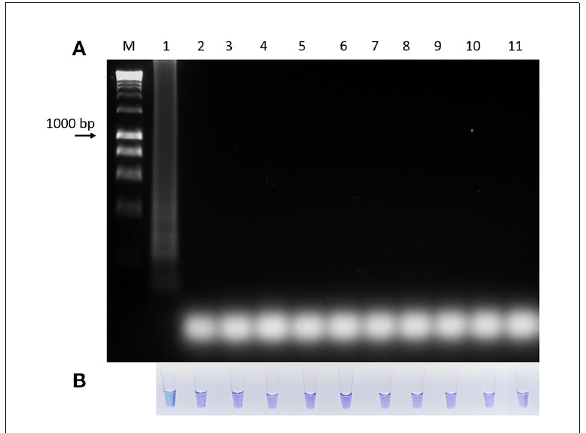
FIGURE4 Diagnostic specificity analysis of the LAMP technique for the detection of B. bigemina . (A) Electrophoresis in agarose gel at 1.2% of the products obtained from the specificity analysis. (B) Colorimetric test with hydroxynaphthol blue. Lanes: M) Molecular size marker in bp: (1) B. bigemina , (2) B. bovis , (3) Anaplasma marginale , (4) A. phagocytophilum , (5) A. centrale , (6) Trypanosoma theileri , (7) bovine, (8) human, (9) Rhipicephalus microplus , (10) Neospora caninum , and (11) Negative